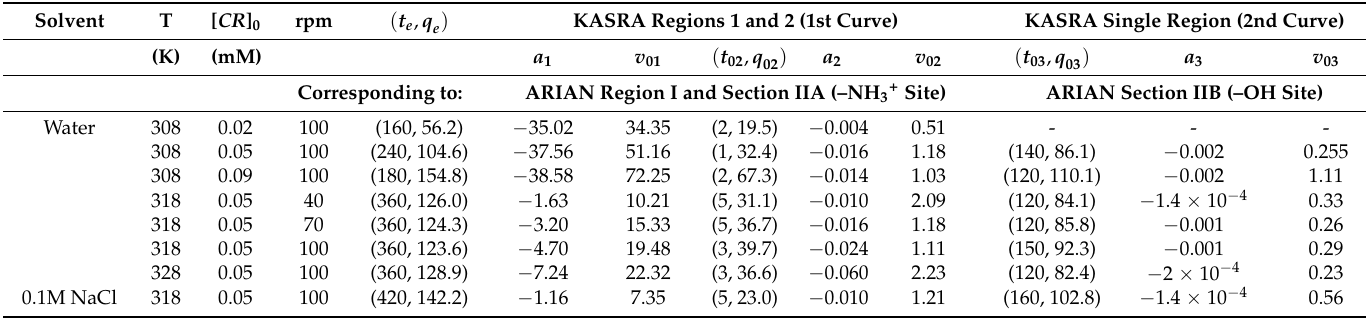
Table 6. Experimental t e , q e , t 02 , q 02 , t 03 and q 03 values and coefficients of the KASRA equation for kinetics of CR adsorption on GO/PAMAM at different temperatures and in various shaking rates and initial CR